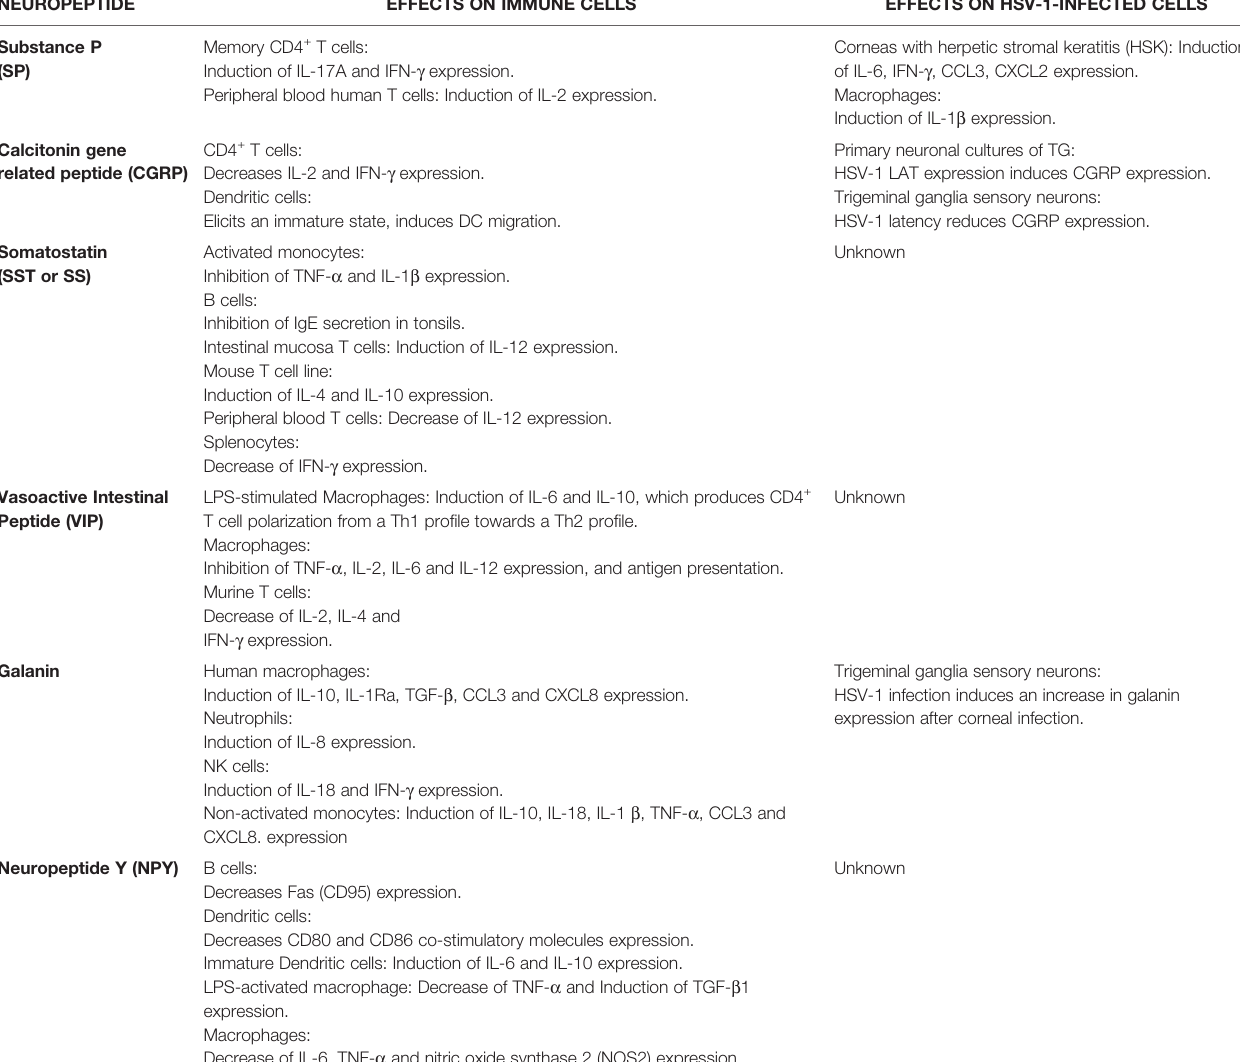
TABLE 2 | Summary of neuropeptide effects on immune cells and HSV-1-infected cells.